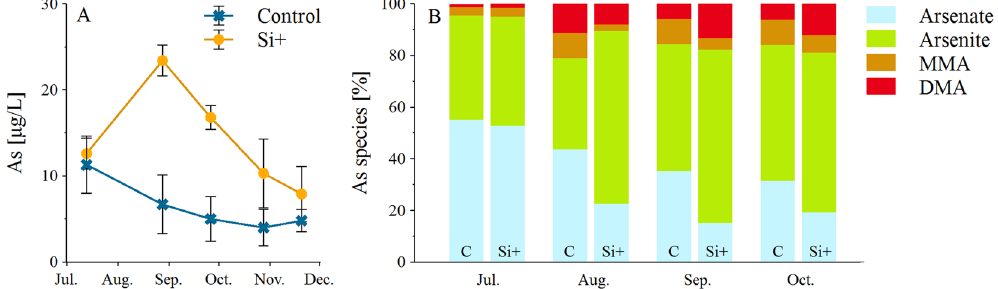
Figure 3. Mean ± SD values of total As and percentage share of As species in pore water under high (Si + ) and low (control) Si availability, n =